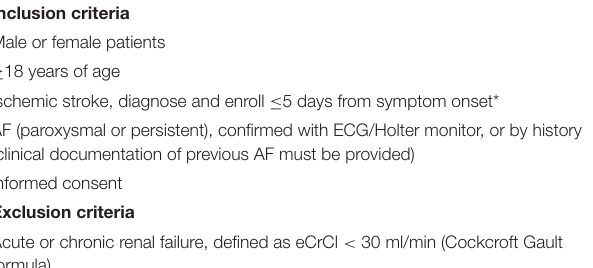
TABLE 1 | Study inclusion and exclusion criteria. Inclusion